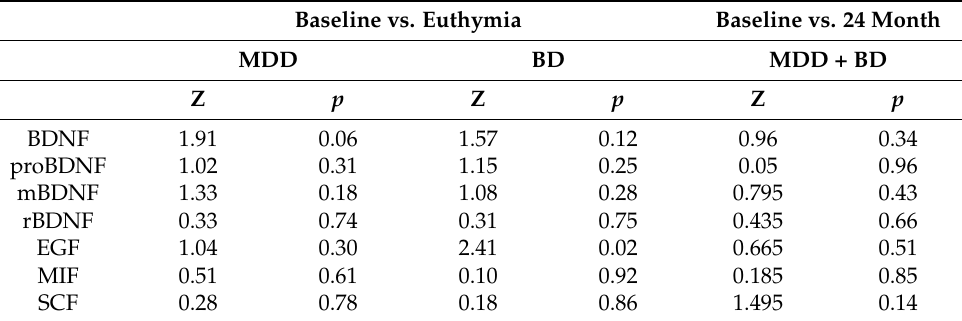
Table 3. Longitudinal comparisons of brain-derived neurotrophic factor (BDNF), precursor BDNF (proBDNF), mature BDNF (mBDNF), BDNF/proBDNF ratio (rBDNF), epidermal growth factor (EGF), migration inhibitory factor (MIF), and stem cell factor (SCF) levels. Baseline vs.